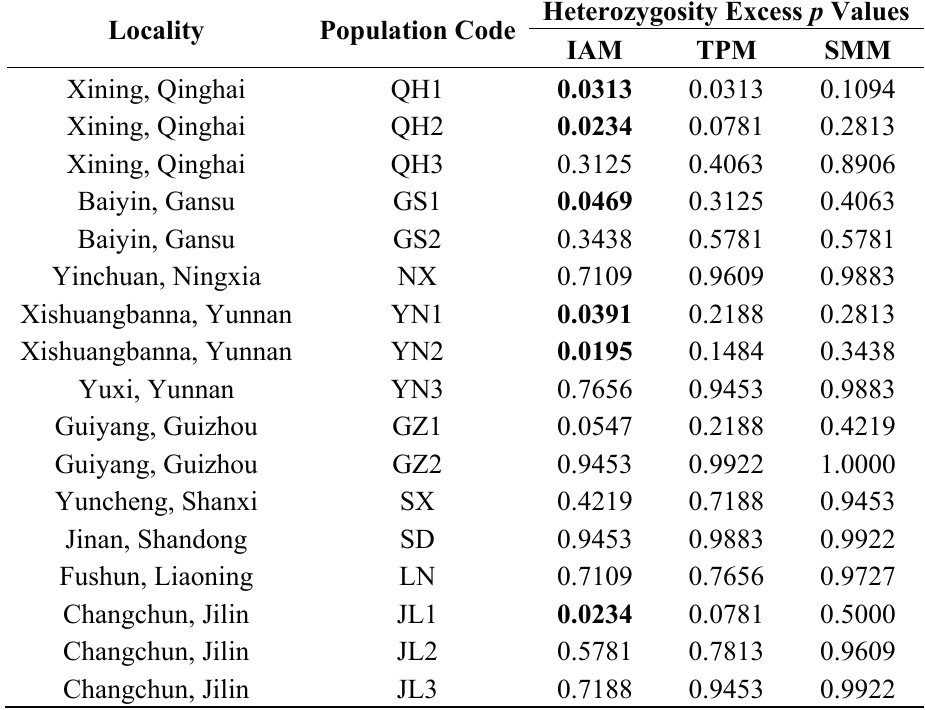
Table 2. Comparison of the within-population tests for heterozygosity excess tests using the models IAM (infinite allele model), TPM (two-phase mutation model), and SMM (stepwise mutation model) in BOTTLENECK.